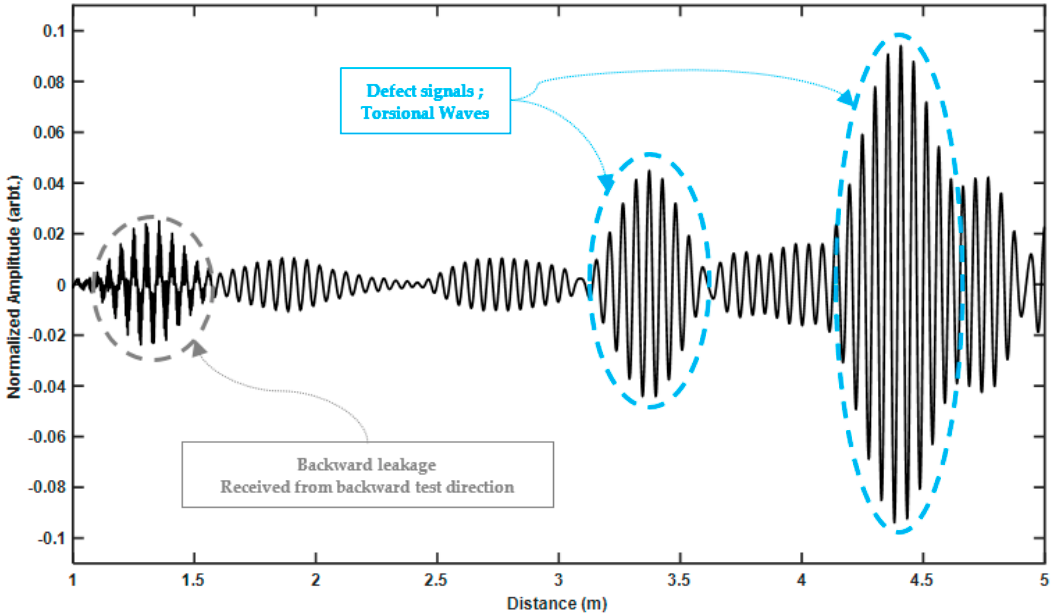
Figure 5. Synthesised data generated from finite element model (FEM) test case.